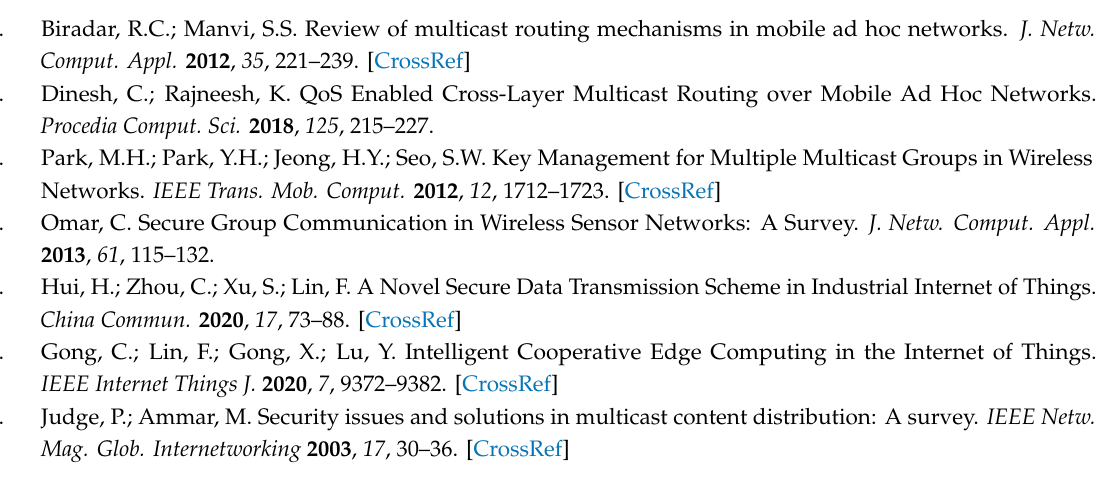
Figure 5. Compare time latency between GKMSFC and Scheme [45,46].